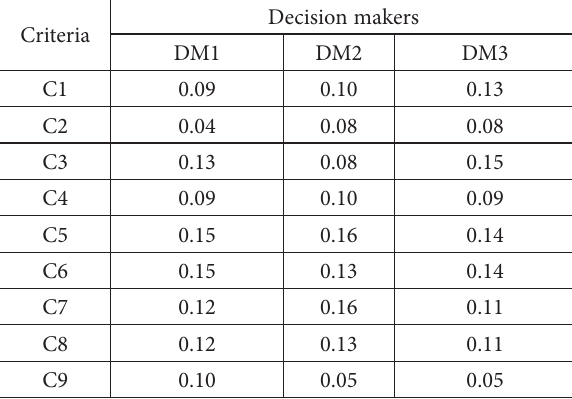
Table 6. Weights of criteria based on each decision maker